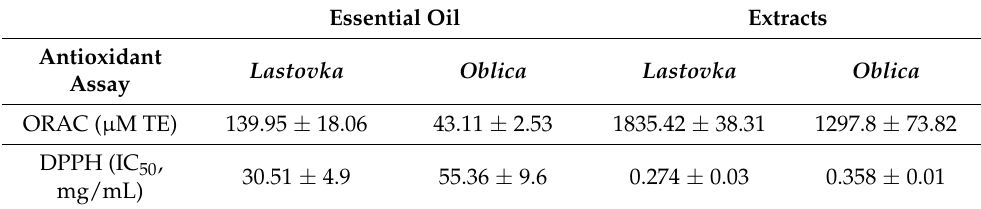
Table 3. Antioxidant potential of essential oils and extracts from the olive buds. Essential Oil Extracts Antioxidant Lastovka Oblica Lastovka Oblica Assay ORAC ( µ M TE) 139.95 ± 18.06 43.11 ± 2.53 1835.42 ± 38.31 1297.8 ± 73.82 DPPH (IC 50 , 30.51 ± 4.9 55.36 ± 9.6 0.274 ± 0.03 0.358 ± 0.01 mg/mL)